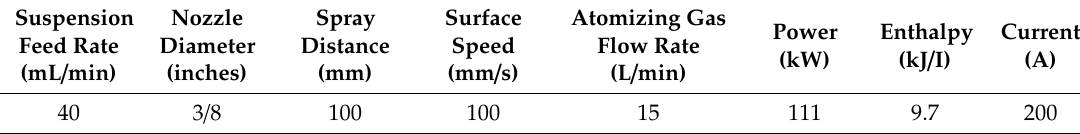
Table 1. Spray parameters used for depositing TiC and Cr 3 C 2